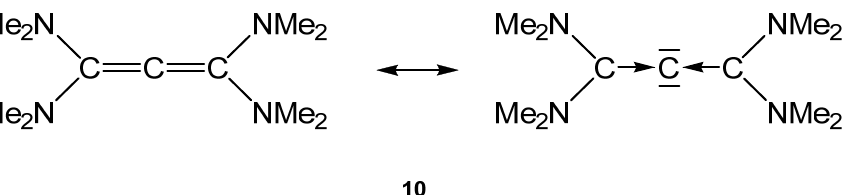
Figure 13. Bonding description of tetraaminoallene (TAA) ( 10 ). TAA’s may have a bent geometry with hidden or masked pairs of electrons, which are delocalized but serve as double donor orbitals in complexes with CO 2 and CS 2 [96].